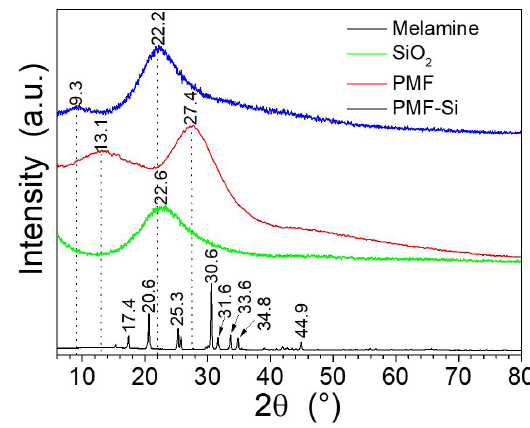
, PMF, and PMF-Si 2